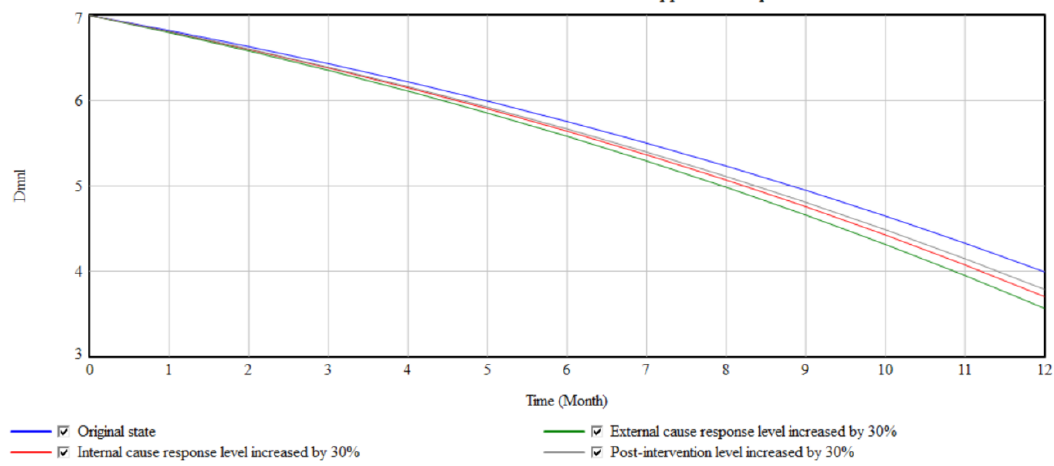
Figure 13. Comparative analysis graph of intervention effects in different scenarios.